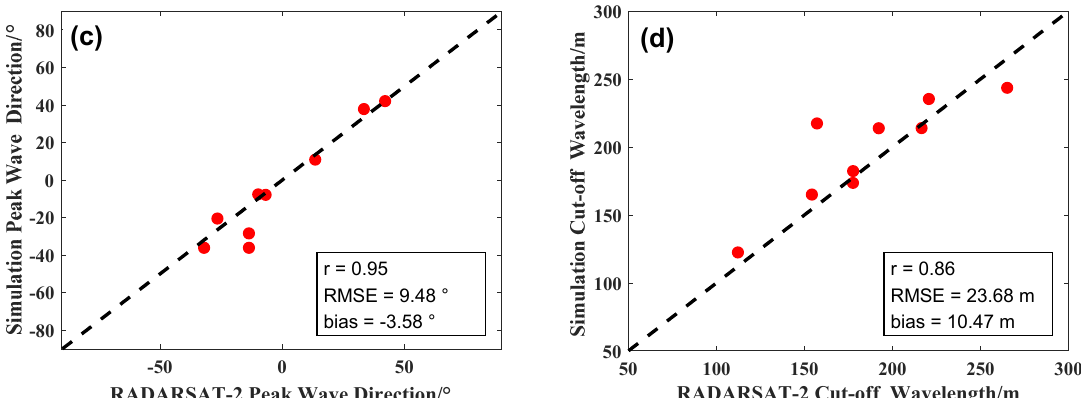
Figure 6. Scatter plots between the parameters obtained from the simulated SAR image spectra and those obtained from the RADARSAT-2 SAR image spectra. ( a ) The maximum spectral density; ( b ) the wavelength; ( c ) the propagation direction of the dominant wave; ( d ) the azimuthal cut-off wavelength. The dotted lines are diagonal lines for reference.